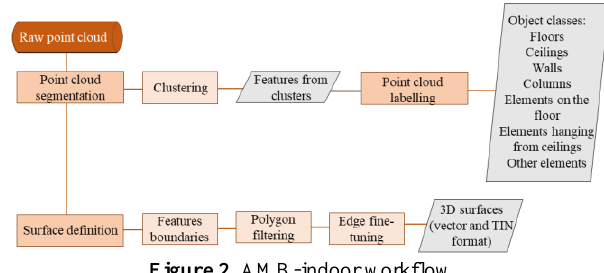
Figure 2. AMB-indoor workflow